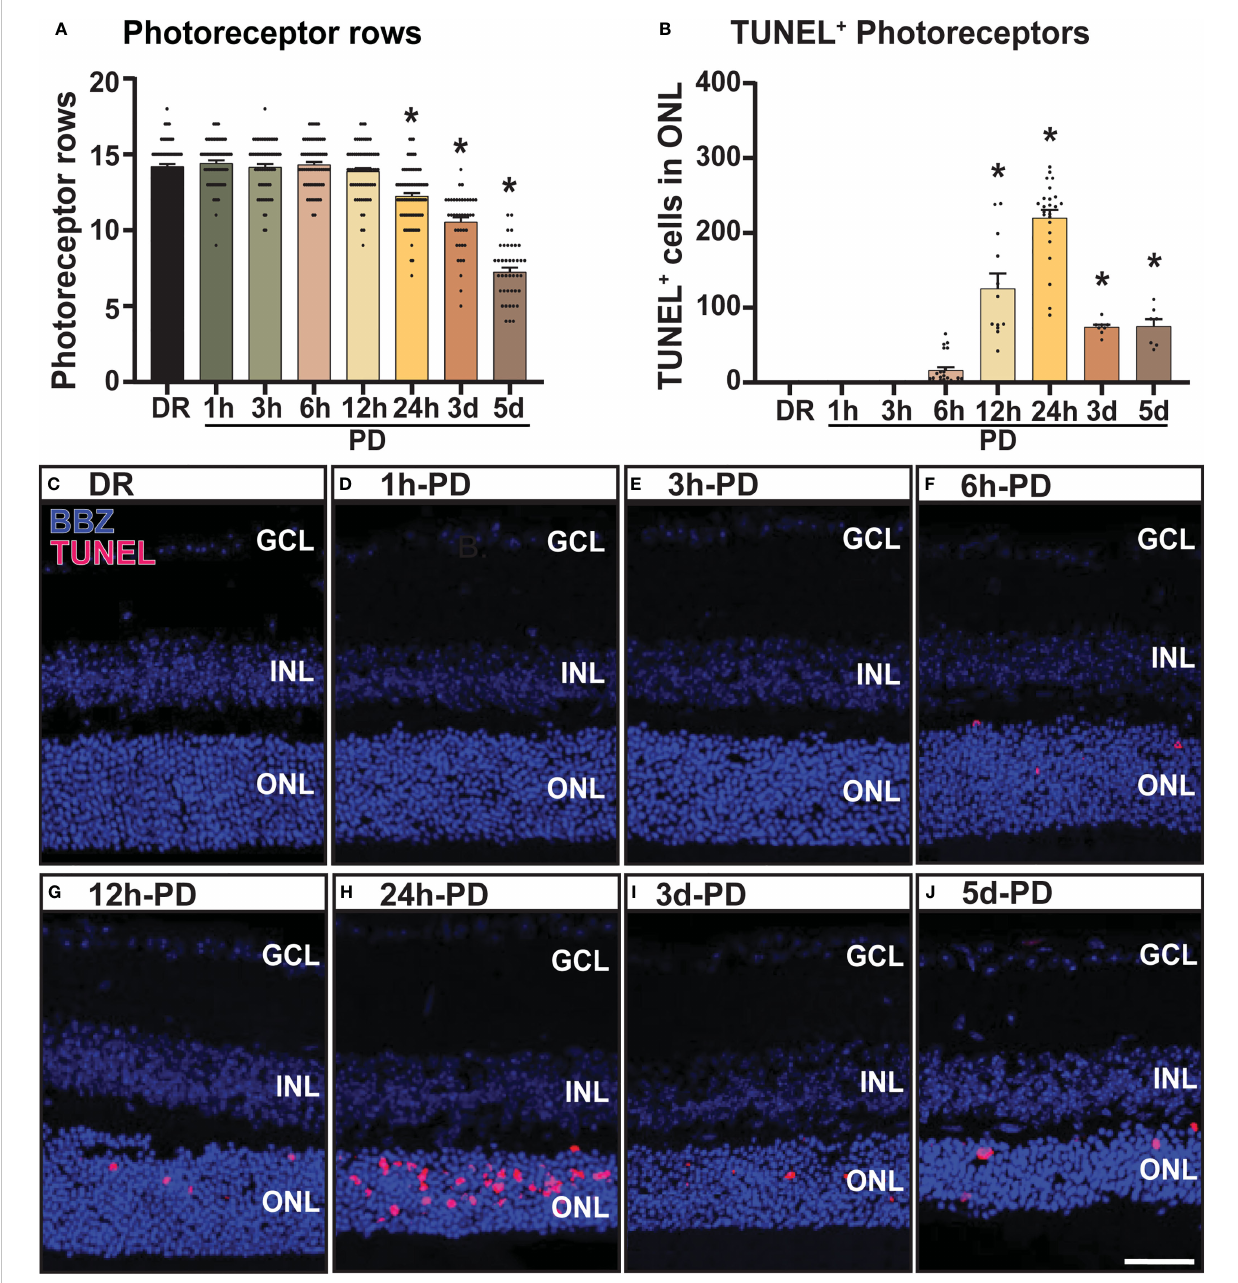
FIGURE 1 Photoreceptor cell death and outer nuclear layer thinning within 24 hours of photo-oxidative damage induced retinal degeneration. (A) Photoreceptor row counts on retinal cryosections of mice exposed to 1h-, 3h-, 6h-, 12h- and 24h-PD, showed a signi fi cant and progressive loss of photoreceptor rows from 24h-PD, compared to DR controls. (B) TUNEL + cells (red) in the ONL were signi fi cantly increased compared to DR controls from 12h-PD to 5d-PD, with peak number of TUNEL + cells at 24h-PD. (C – J) Representative confocal images depict progressive ONL thinning between (G) 12h-PD and (J) 5d-PD, and increased TUNEL + cells in the ONL from (F) 6h-PD, peaking at (H) 24h-PD. *Signi fi cance using a one-way ANOVA, p < 0.05 and error bars indicate SEM. Scale bar = 50 m M. n = 12. Ganglion Cell Layer (GCL), Inner Nuclear Layer (INL), Outer Nuclear Layer